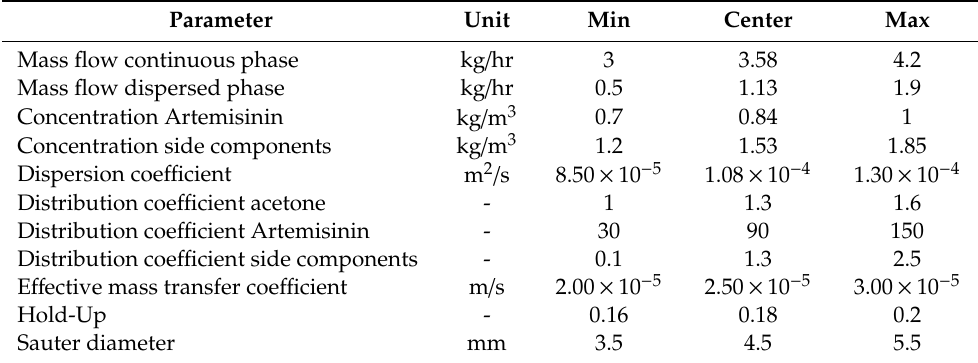
Table 3. Axial dispersion model parameters for the multi-parameter-at-a-time sensitivity analysis.